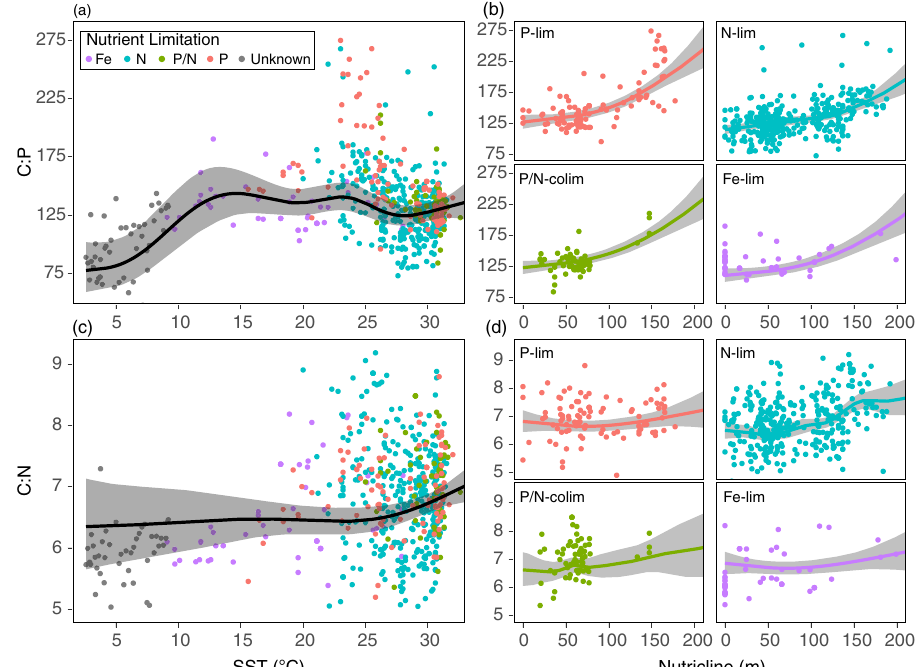
Fig. 4 Observed C:P and C:N as a function of environmental variation. Dots are observed values and colors represent the nutrient limitation type inferred from metagenomes (Purple = Fe-limited, Blue = N-limited, Green = P/N co-limited, Red = P-limited, Grey = Unknown). a , c C:P and C:N against SST. Black line and shade represent GAM prediction and uncertainty (± 2SE) under the constant nutricline depth and surface nitrate values at the observed mean values of 70 m and 0.2 μ mol kg − 1 , respectively. b , d C:P and C:N against nutricline depth for different nutrient limitation types. GAM is fi tted separately for each limiting nutrient type under constant SST and surface nitrate at the observed mean values of 25 °C and 0.2 μ mol kg − 1 ,